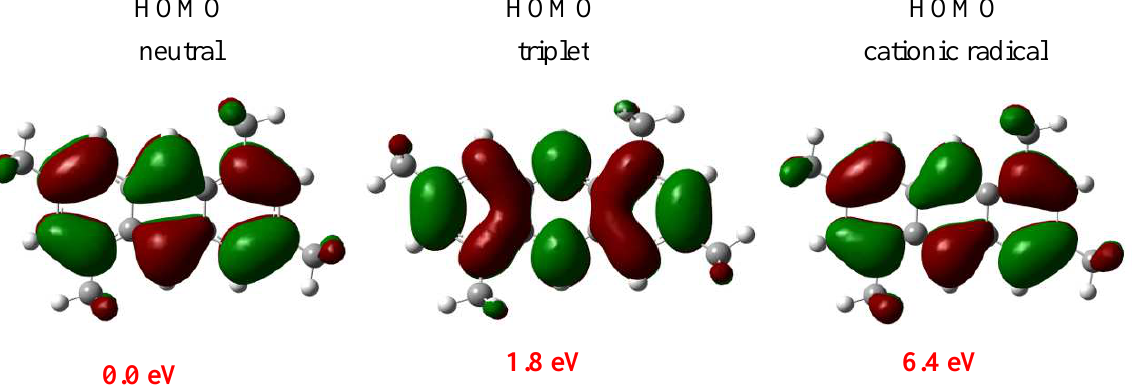
Figure 7. Shape of molecular orbitals.